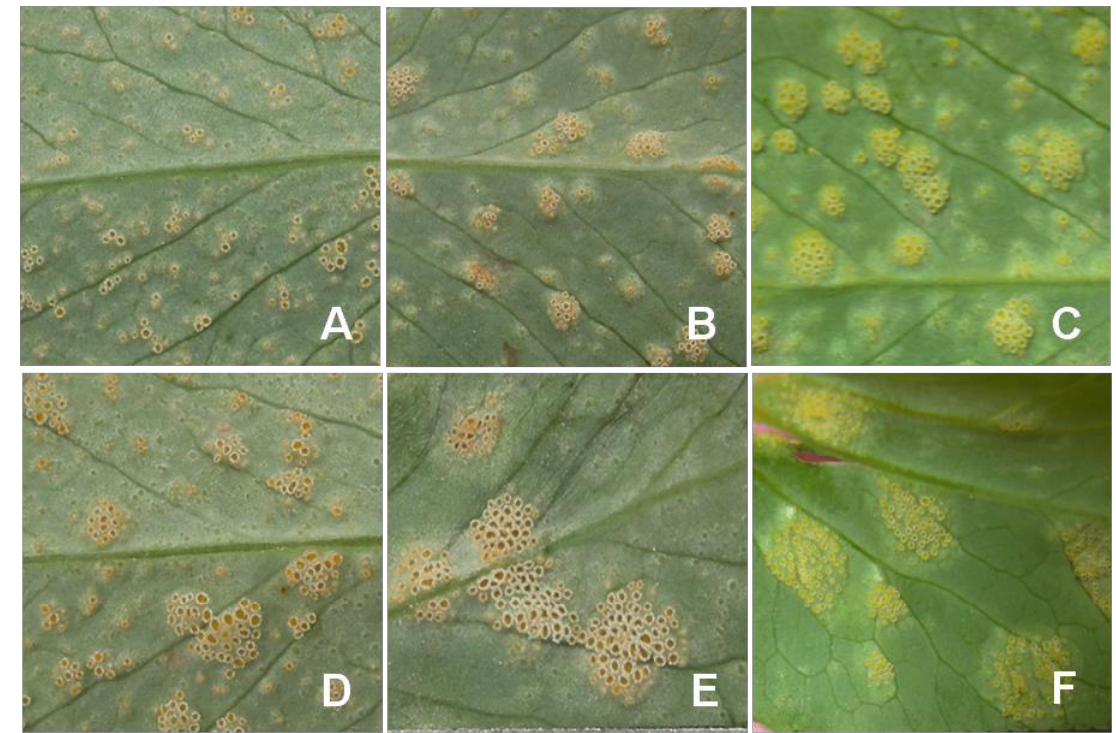
Figure 6. Variation in pustule size of U. viciae-fabae on pea. ( A ) <0.5 mm dia. ( B ) 0.5 – 1.0 mm ( C ) 1.0 – 1.5 mm ( D ) 1.5 – 2.0 mm ( E ) 2.0 – 2.5 mm ( F ) >2.5 mm.